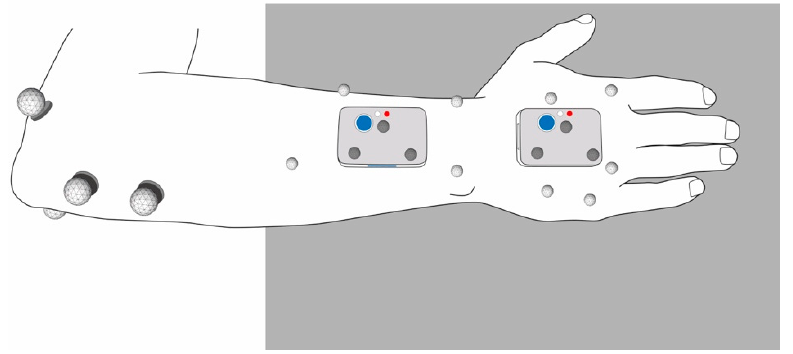
Figure 1. Sensor (IMU), skin marker (light grey, OMC1), and sensor marker (dark grey, OMC2)